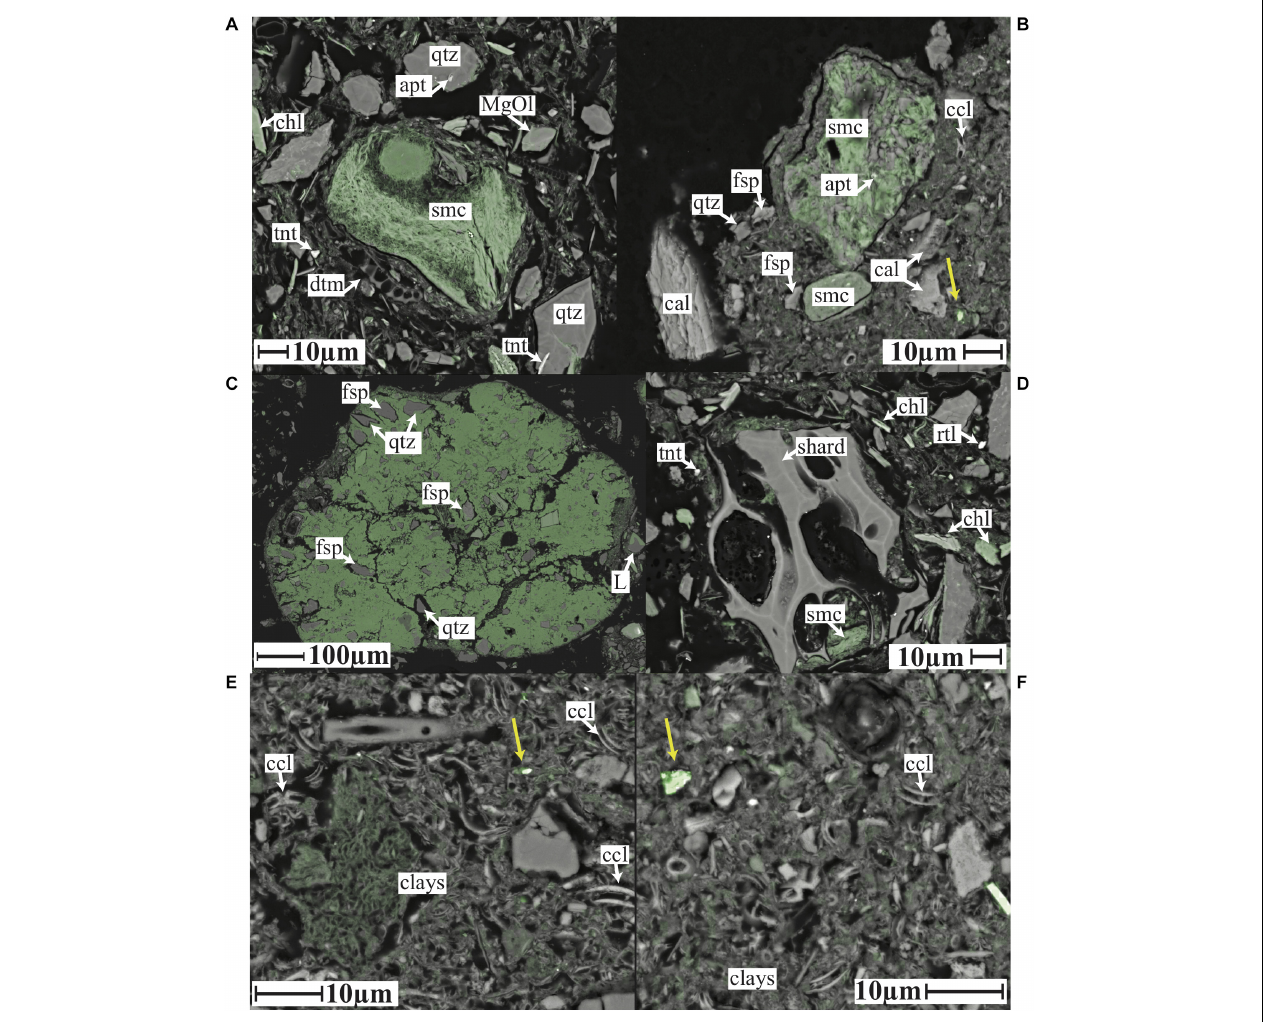
FIGURE 5 | Elemental iron (green) maps overlaid on SEM BSE images of (A) an incipient glauconite grain from NP200 2–3 cm, FeSmc, iron rich smectite (B) sediment grains from TS1500 1–2 cm, (C) an immature glauconite grain from the NP1500 0–1 cm that is low in K, high in iron, (D) volcanic glass shards surrounded by clay minerals from NP200 2–3 cm, and (E,F) iron rich clay aggregations from TS3000 1–2 cm. Small detrital iron oxide grains are visible in panels (B,E,F) as indicated by yellow arrows. All scale bars are 10 µ m except for panel (C) (100 µ m). Selected features labeled as: MgOl, magnesium olivine; apt, apatite; qtz, quartz; scm, smectite; tnt, titanate; chl, chlorite; dtm, diatom; ccl, coccolithophore; cal, calcite; fsp, feldspar; L, lithic grain; rtl,